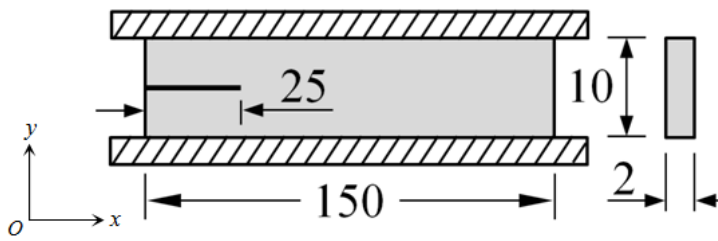
Figure 1. Dimensions of the test specimen (unit: mm).